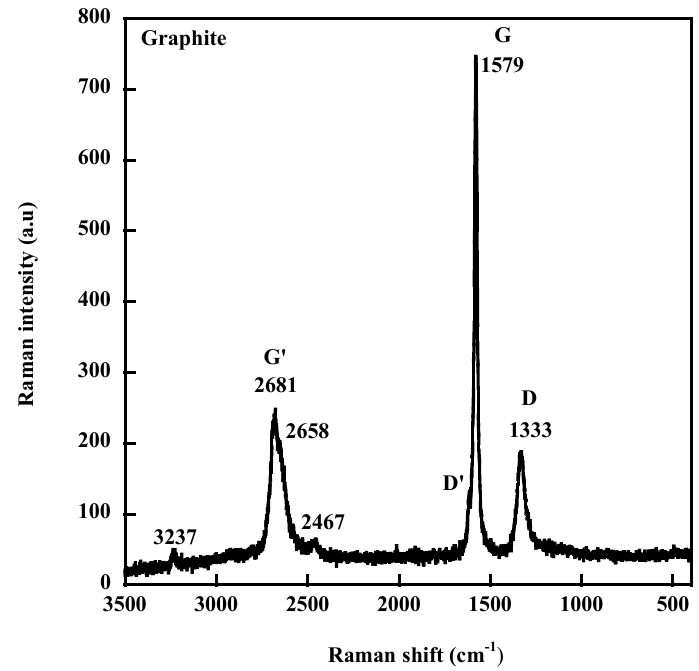
Figure 8. Raman spectrum of a graphite (Graphite 3775 from Asbury Carbons, a surface-enhanced flake graphite with a specific area of 24 m 2 ·g − 1 ) excited at 633 nm.